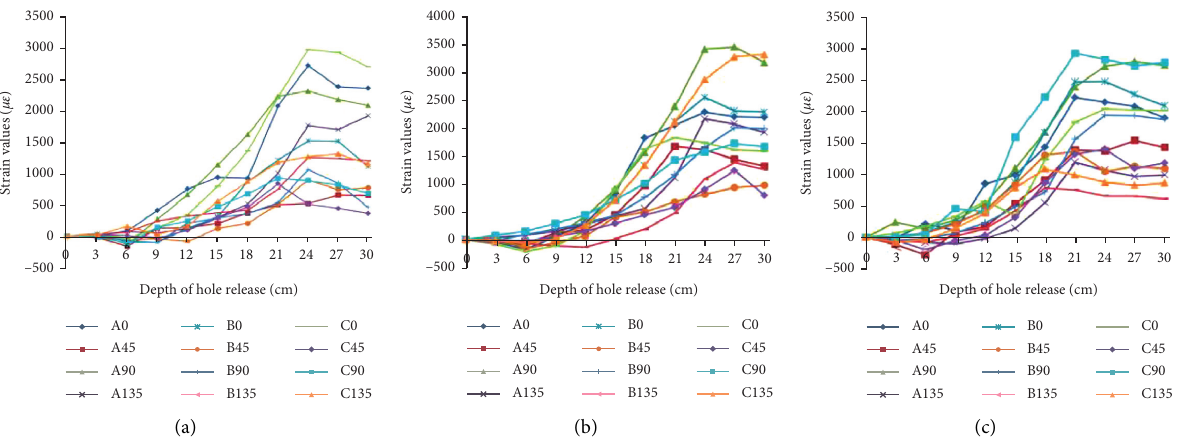
Figure 4: Stress relief curve at measuring point. (a) 1# measuring point. (b) 2# measuring point. (c) 3# measuring